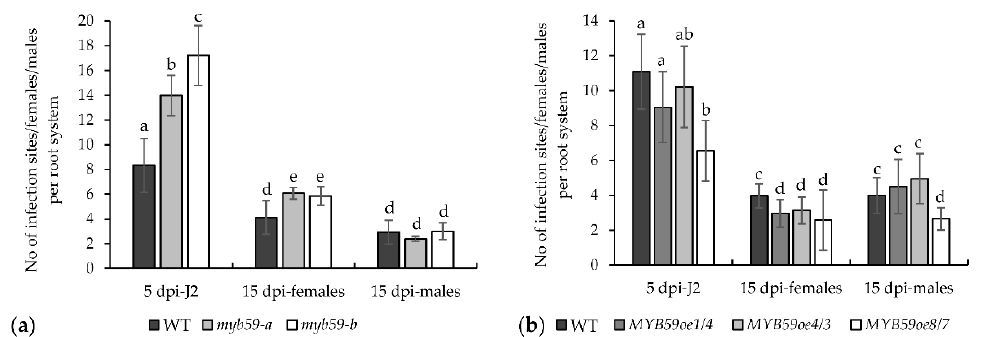
Figure 5. Development of H. schachtii juveniles on wild-type, mutant, and Myb59 overexpressing A. thaliana lines at 5 and 15 dpi; ( a ) developmental test comparing the susceptibility of wild-type and myb59-a and myb59-b mutant plants for infection with beet cyst nematode; ( b ) developmental test comparing the susceptibility of wild-type and different homozygotic Myb59 overexpressing lines ( MYB59oe1/4, MYB59oe4/3 and MYB59oe8/7 ). The bars show mean values ± standard deviation. a, ab, b, c, d, e homogenous groups ( p < 0.05; ANOVA; LSD).